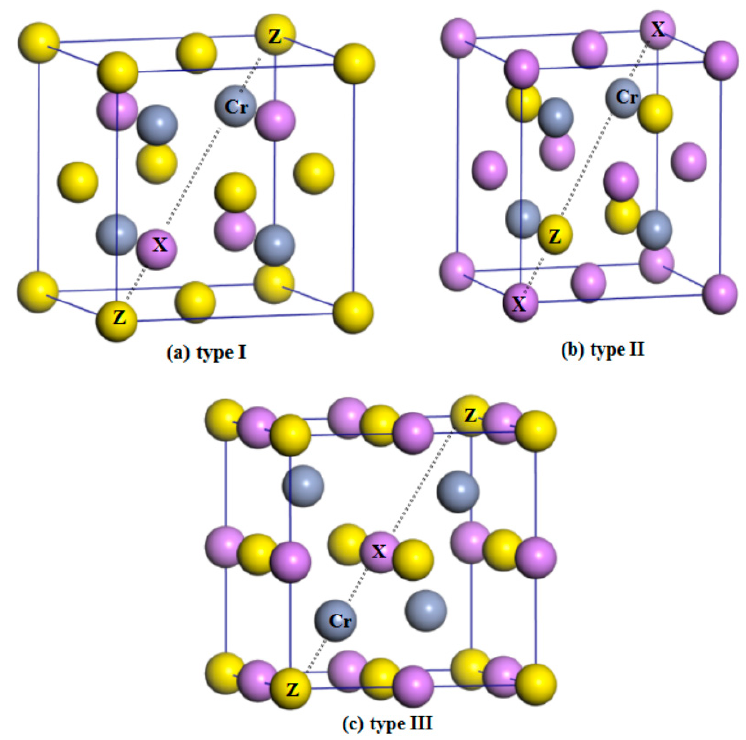
Figure 1. Crystal structures of the three arrangements within the half-Heusler alloys XCrZ (X = Li, K, Rb, Cs; Z = S, Se, Te) noted as type I ( a ); type II ( b ) and type III ( c ).